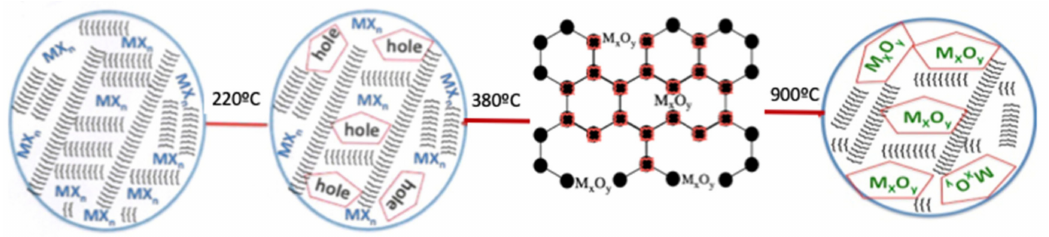
Figure 23. Schematic representation of the proposed mechanism of formation of the metal oxide nanoparticles. MX n represents the general formula of the metallic salt coordinated to the Chitosan and PSP-4-PVP polymer, }}}}}}} represents the Chitosan and PSP-4-PVP polymer. M x O y represents the respective metal oxides formed inside the graphite matrix. The given temperatures are referential general